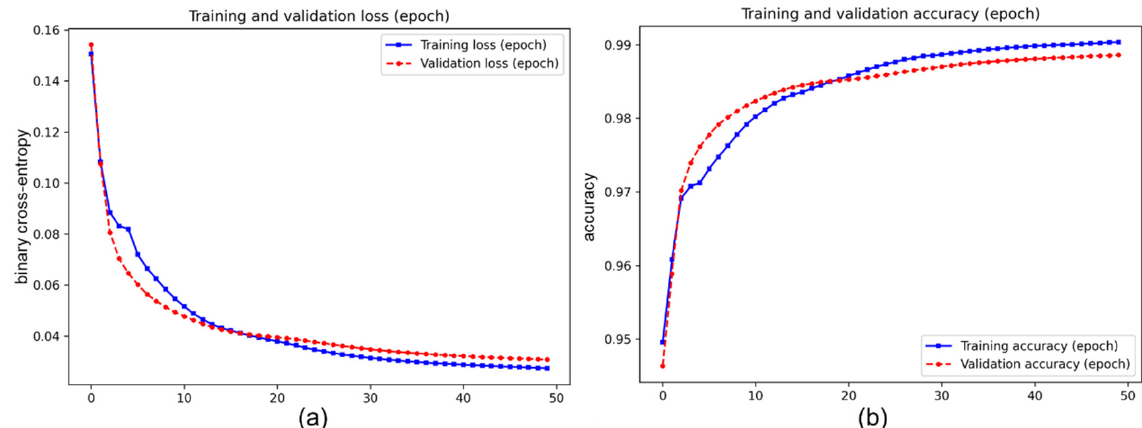
Figure A8. The loss and accuracy curves of Furlan2019 [43] using the synthetic dataset. ( a ) Refers to the epoch-wised loss curves in the training and validation sets. ( b ) Refers to the epoch-wised accuracy curves in the training and validation sets.